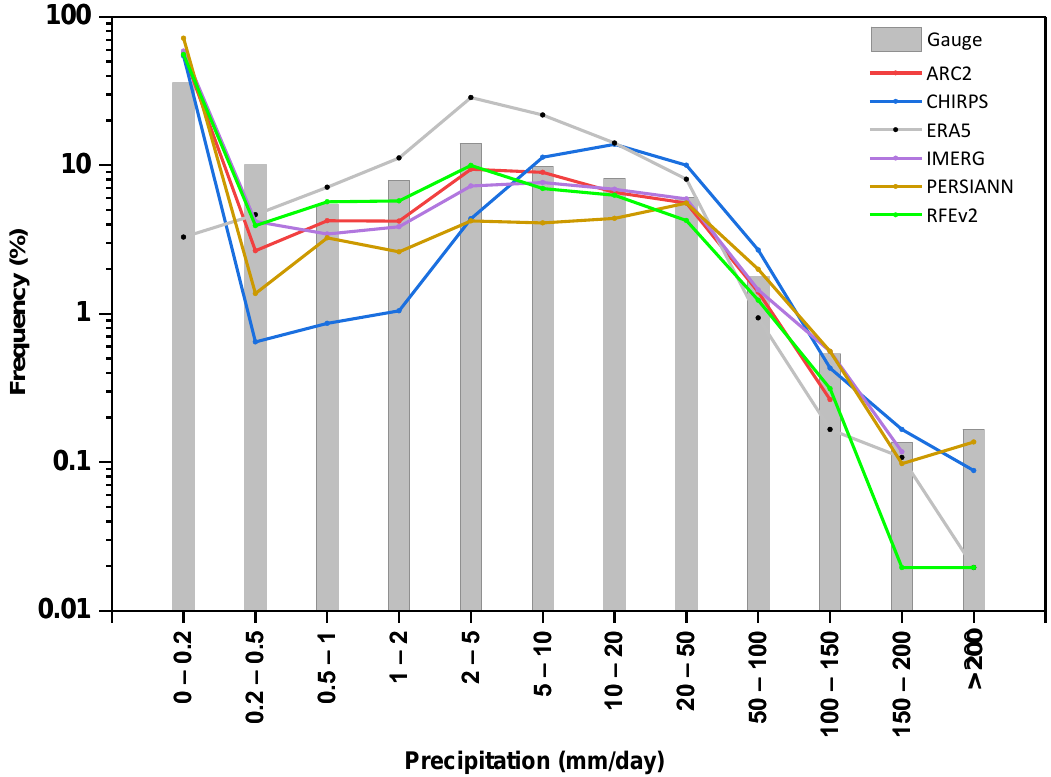
Figure 5. Probability distribution function (PDF) of daily rainfall intensities based on GPP and rain gauge data from September 2018 to August 2020. Note logarithmic (Log10) scale for Y axis.